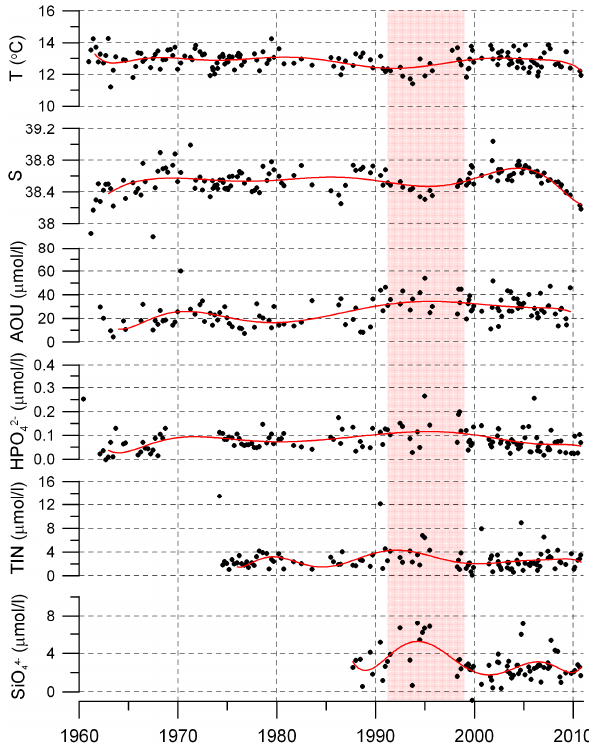
Fig. 6. Time series of pH values recorded at different depths of sta- tion Figure 6. Time series of pH values recorded at different depths of station P5.